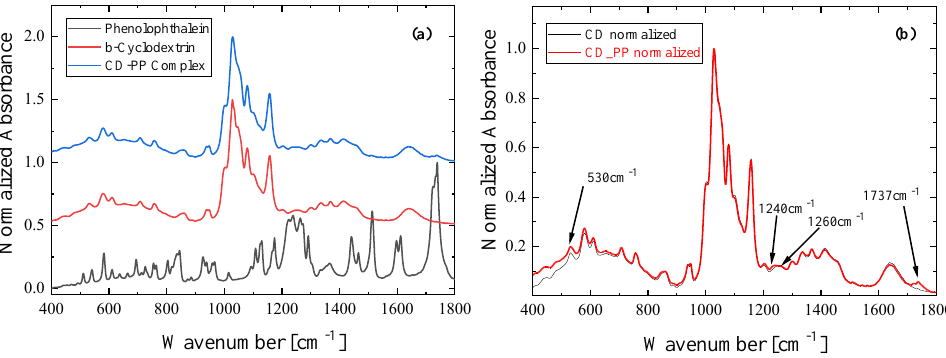
Figure 5. ( a ) Normalized FT-IR spectra of phenolphthalein, β -cyclodextrin and the PP–CD complex. Figure 5. (a) Normalized FT-IR spectra of phenolphthalein, β -cyclodextrin and the PP – CD complex. (b) Normalized FT- IR spectra of β -cyclodextrin and CD – PP for direct comparison. ( b ) Normalized FT-IR spectra of β -cyclodextrin and CD–PP for direct